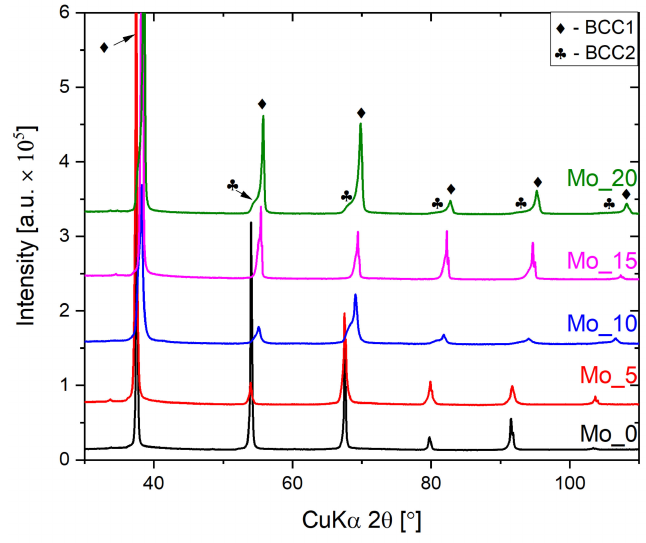
Figure 2. Measured X-ray diffraction patterns for all studied high entropy